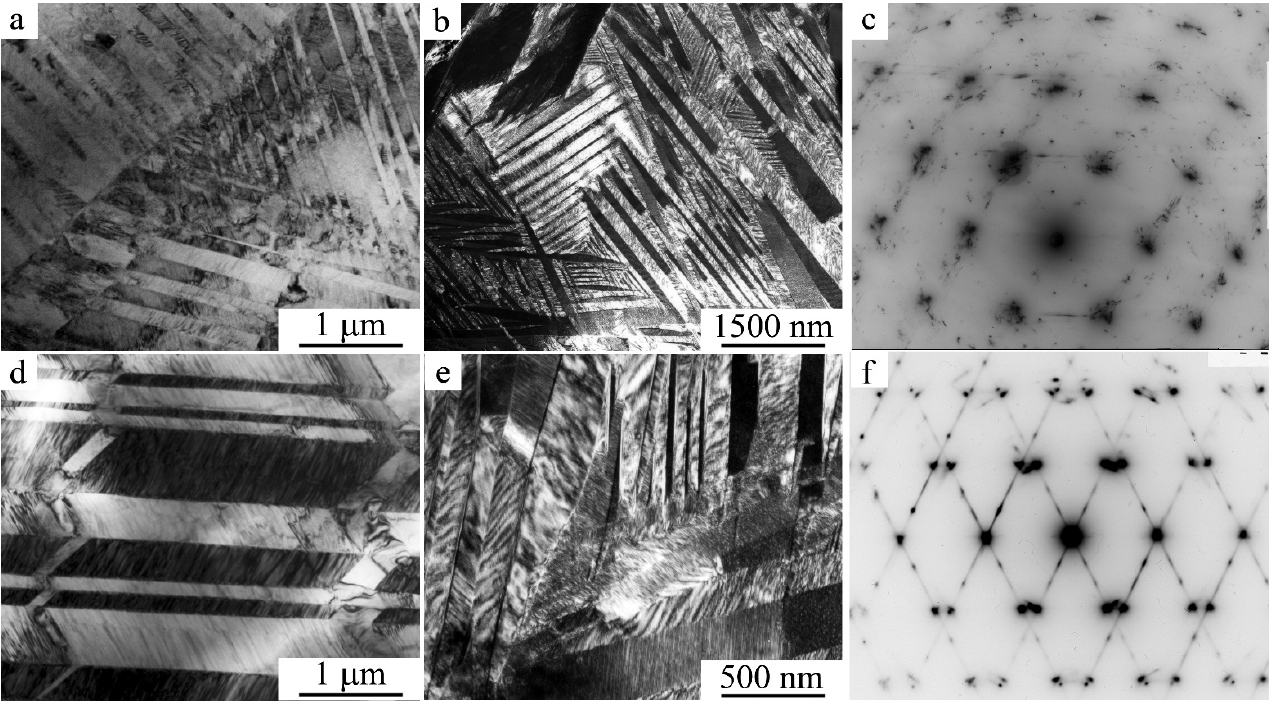
Figure 4. ( a , d ) Bright- and ( b , e ) dark field TEM images of ( a – c ) γ ’ 1 or ( d – f ) β ’ 1 martensites of Cu-Al-Ni quenched alloys [46].